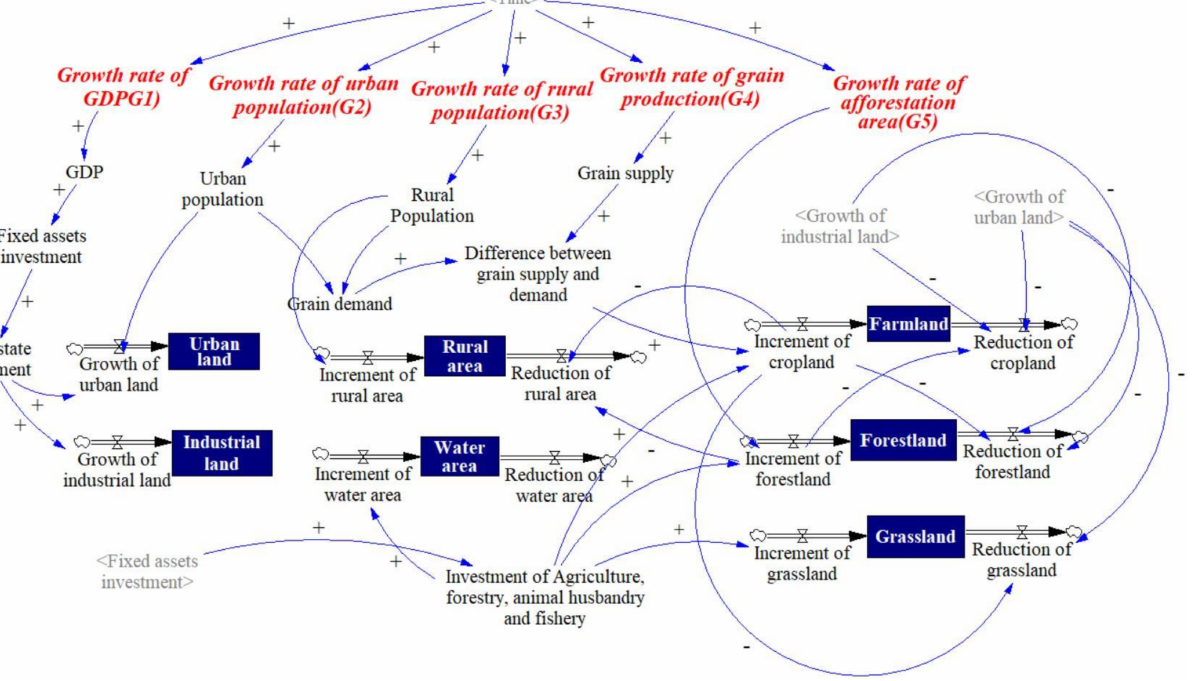
Figure 4. SD model of land-use demand projection. The symbols of + and − indicates the influence of the former to the latter, respectively positive influence and negative